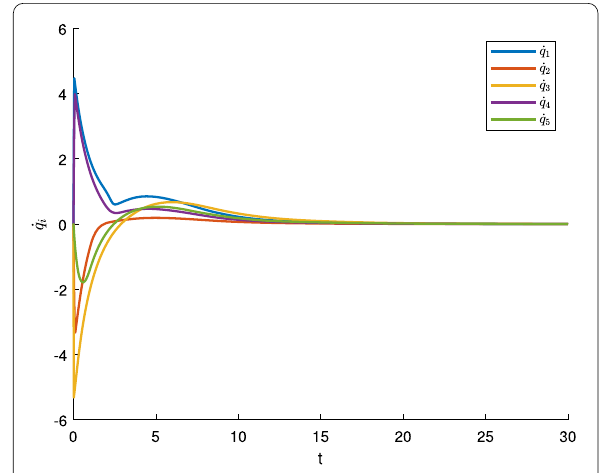
Figure 11 The velocity trajectories of generator systems (33a)–(33b) under the proposed protocol